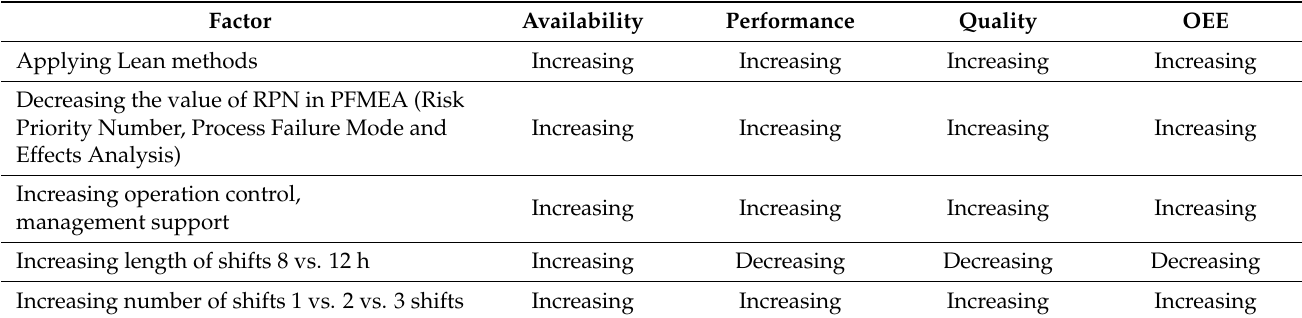
Table 2. Methods and